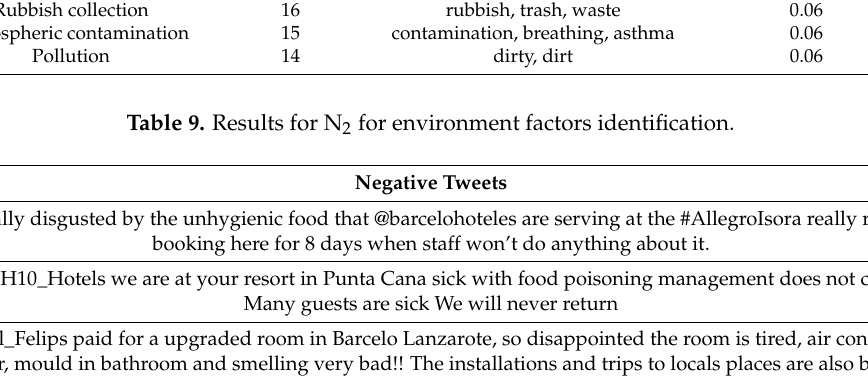
Table 10. Results for N 2 for environment factors identification.